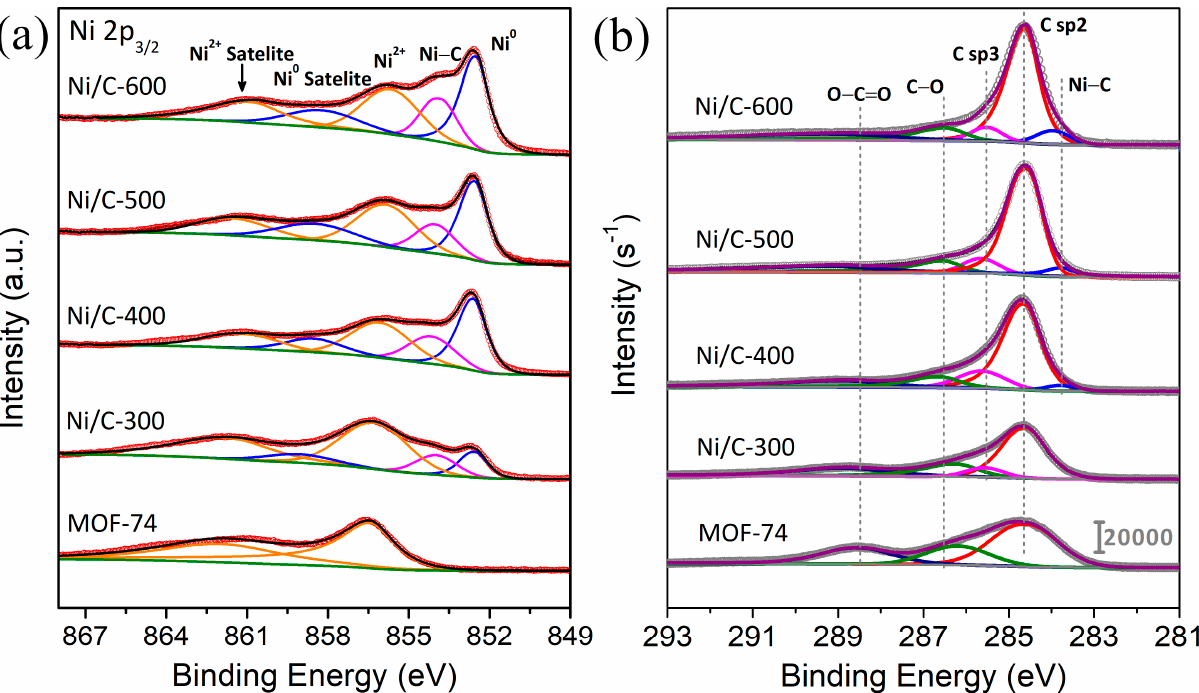
Figure 4. ( a ) Ni 2p3/2 XPS spectra and ( b ) C 1s XPS spectra of the MOF-74 and Ni/C derivatives prepared at various temperatures.